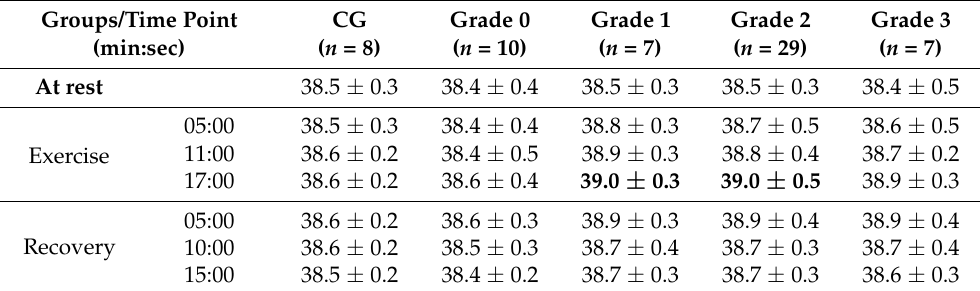
Table 6. Body temperature (°C) in the control group (CG) and pugs subdivided into BOAS grades 0–3.